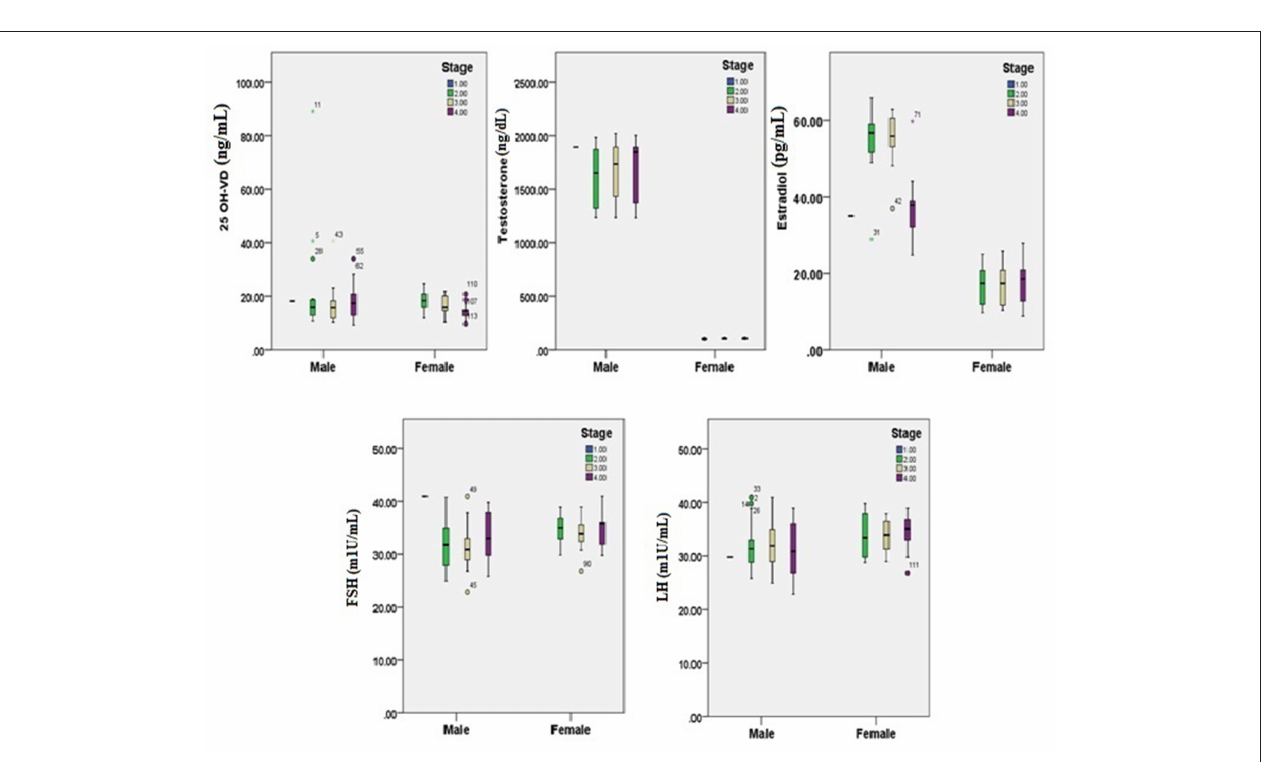
menopause, age at menarche is a marker of the period of exposure to cyclic ovarian function (48, 49). Studies have confirmed an inverse association between circulating estrogen level and age